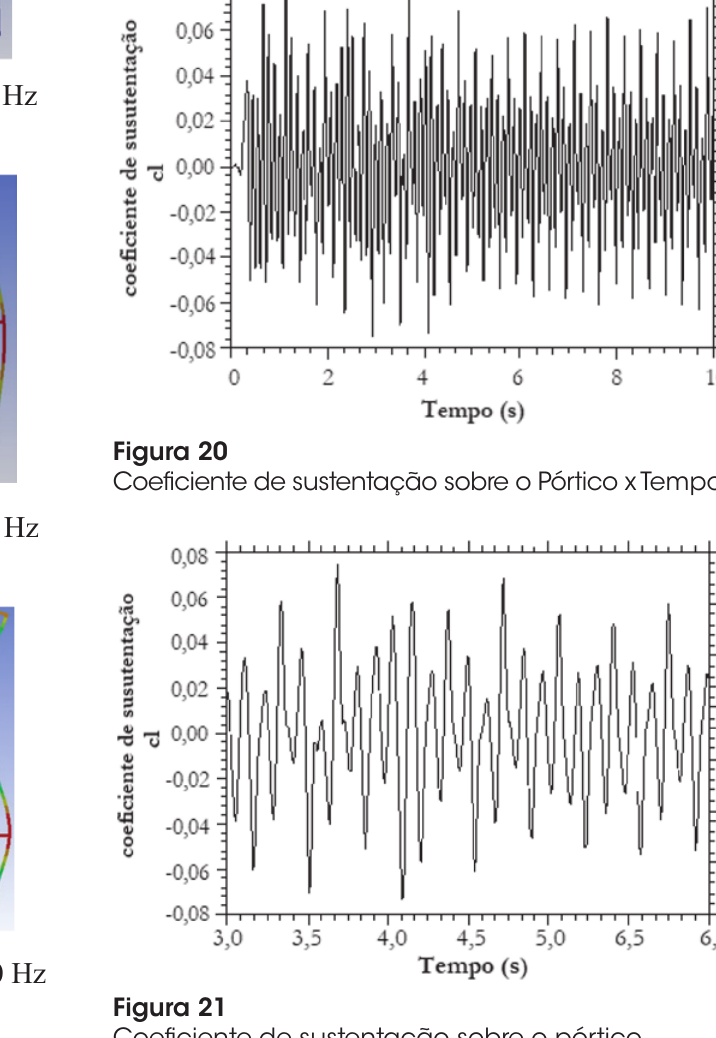
Figura 19 Modo de vibração: (a), (b), (c) por RFP ;(d),(e),(f) por FEM (ANSYS)